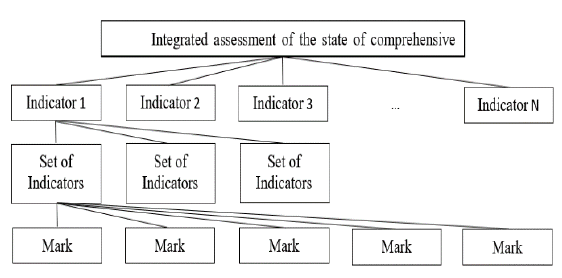
Fig. 1. Hierarchy u sed t o as sess t he s tate o f co mprehensive